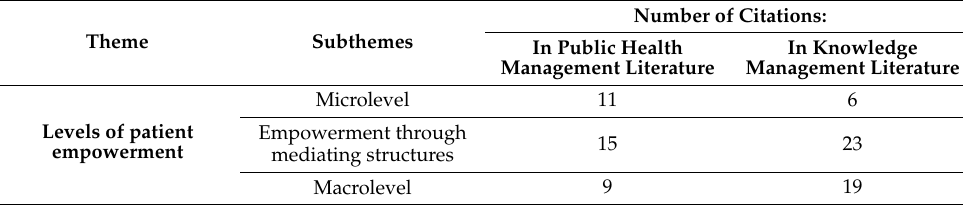
Table 4. Synthesis of topics for patient empowerment levels (source: own